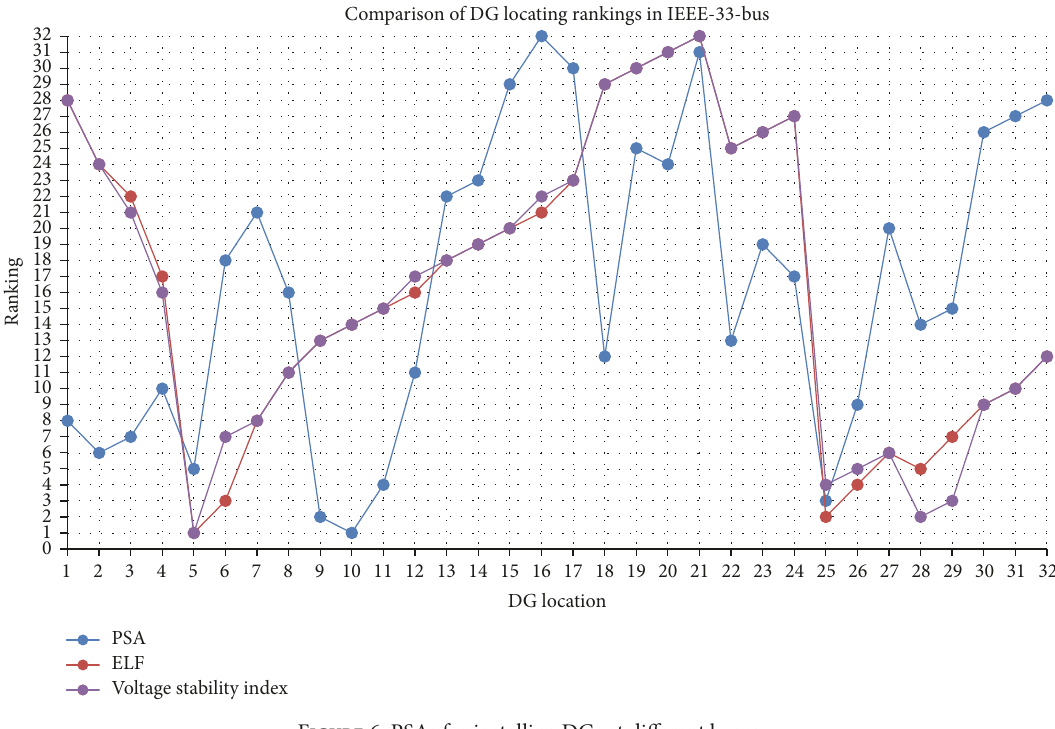
Figure 6: PSAs for installing DGs at different buses.